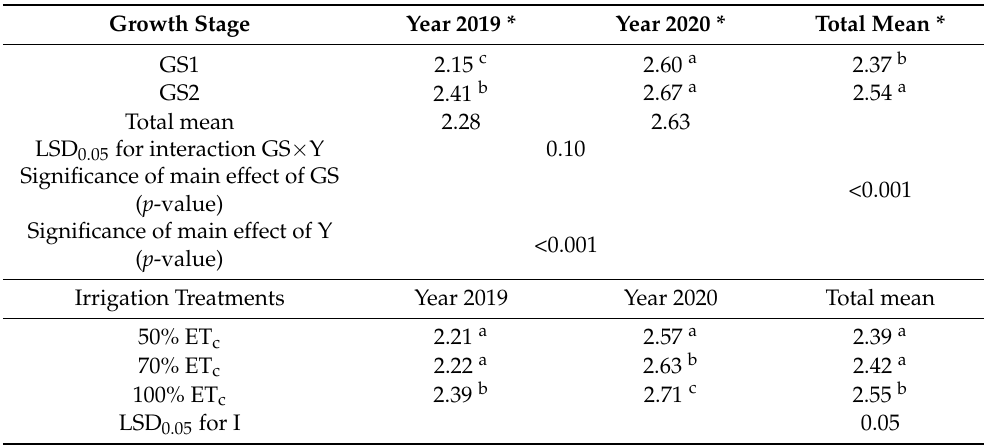
Table 3. Plant height (m) for the two years 2019 and 2020, for two growth stages. Data presented are mean values, where LSD 0.05 is the Least Significant Difference at the 0.05 significance level. Growth Stage